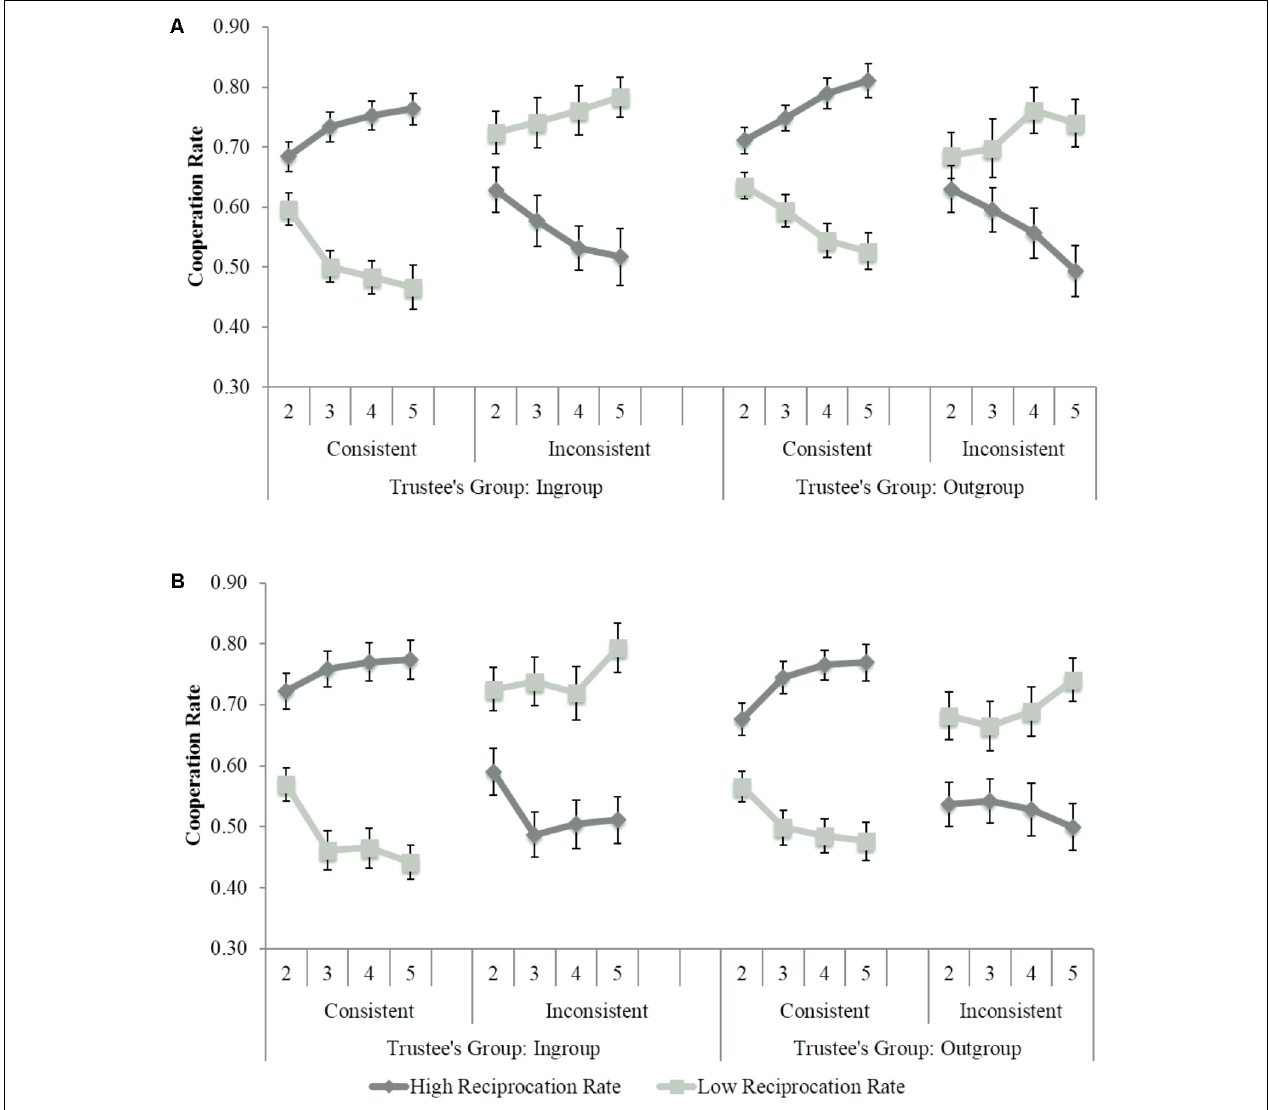
FIGURE 3 | Participants’ cooperation rates in Study 2 as a function of trustees’ group, individual consistency and blocks of trials. (A) White Experimenter Condition. (B) Black Experimenter